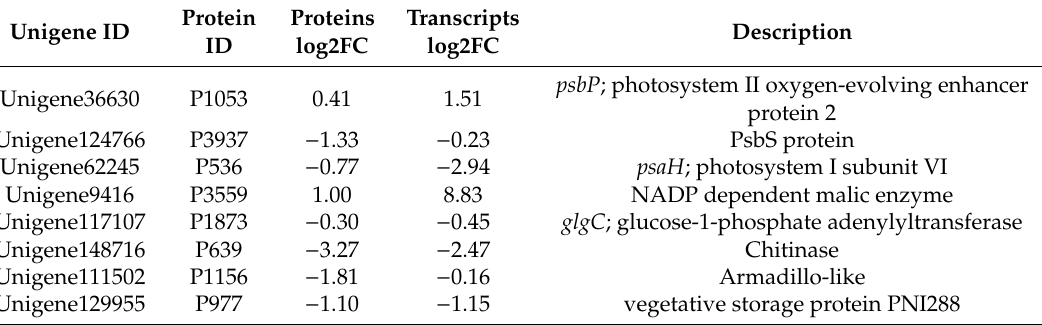
Table 4. Correlation analysis of the differentially expressed proteins and differentially expressed genes.